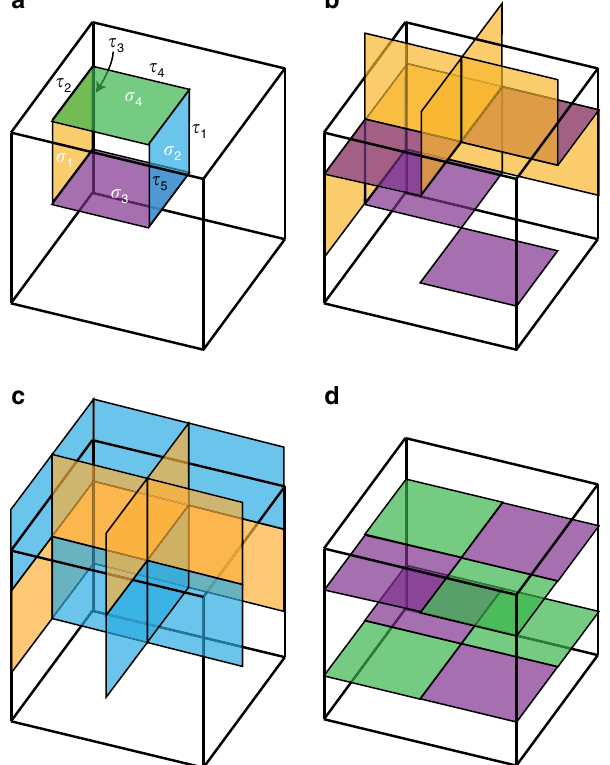
Fig. 5 A 2D construction beyond layer construction. a The inequivalent 2- cells and 1-cells of the space group P (cid:1) 4 n 2. b – d The three Z the crystalline states. b is beyond layer construction, and ( c , d ) are equivalent with layer constructions. The equivalent 2-cells are colored in the same colors. See Sec. VI of Supplementary Information for the de fi nitions of the 2-cells and